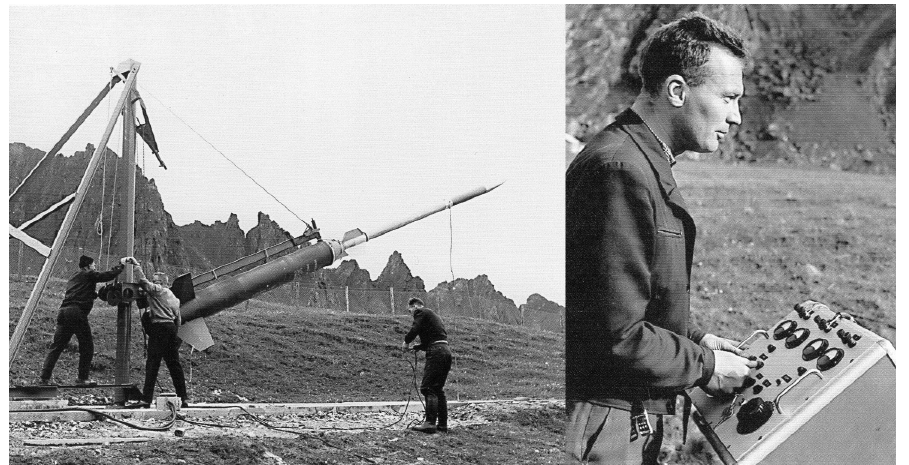
Figure 1. Preparations for the launch of Ferdinand 1.